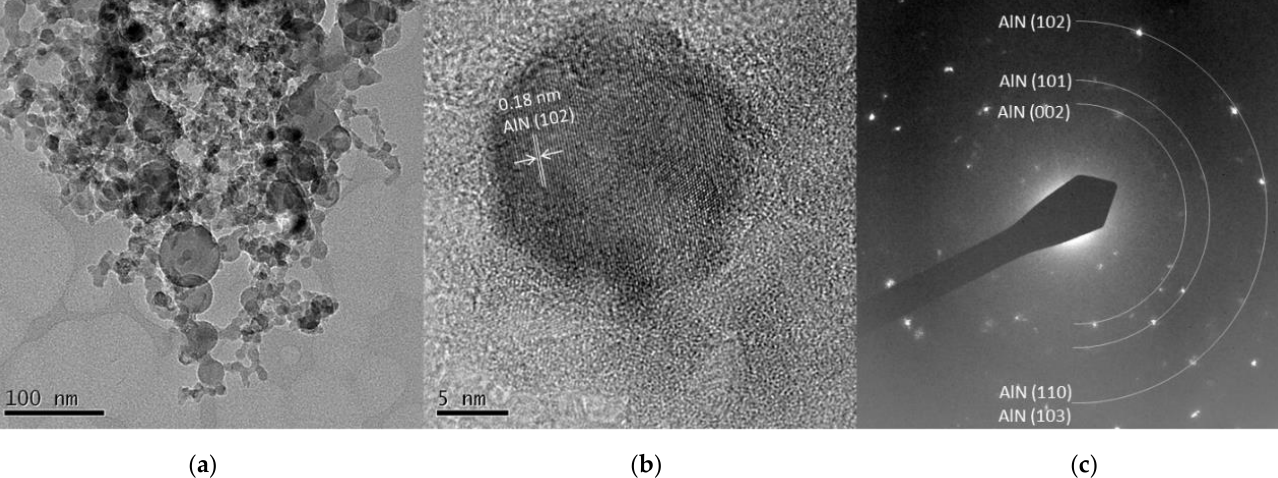
( c ) Figure 8. TEM images of Al 30 A particles ( a ) low resolution image; ( b ) high resolution image; ( c ) SAED pattern Cu 5 A and Cu 30 A Figures 9a and 10a show spherical particles and grain-like dark particles, the latter of which were placed on the surface of the spherical particles. The shape of the particles also corresponded to the FE-SEM observation shown in Figure 3. High-resolution images in Figures 9b and 10b show that the grain-like particles had crystal lattice structures. The estimated lattice plane spacing of 0.13, 0.18, 0.21, and 0.11 nm corresponded to the Cu (220), Cu (200), Cu (111), and Cu (311) planes, respectively. The SAED pattern showed a dotted ring pattern, which meant a crystalline particle. According to the TEM observation, crystallized Cu nanoparticles were obtained in this method.